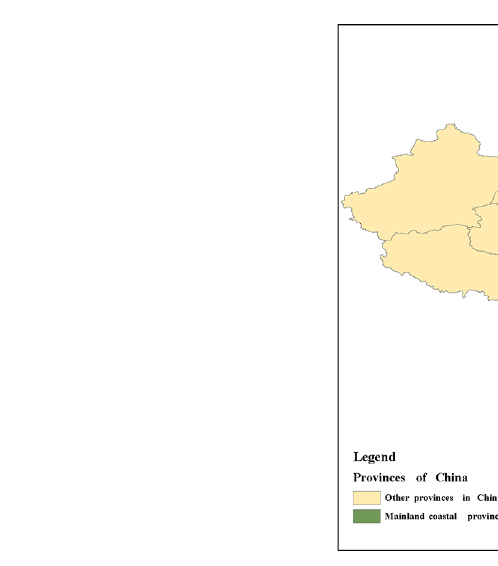
FIGURE 4 Coastal provinces in mainland